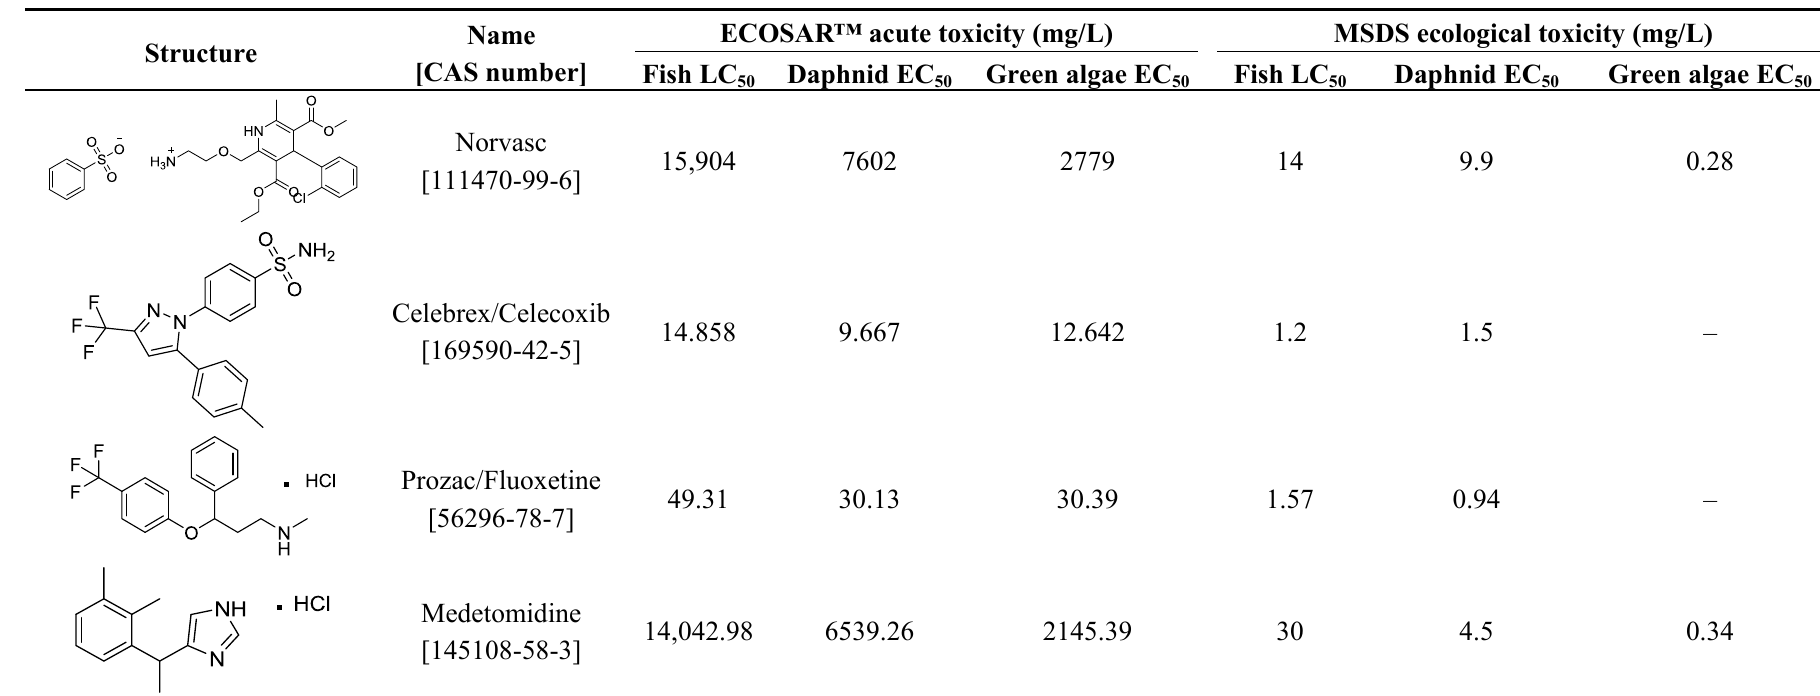
Table 5. Comparison of predicted ECOSAR™ toxicity against Material Safety Data Sheets (MSDS) data for selected pharmaceuticals and veterinary